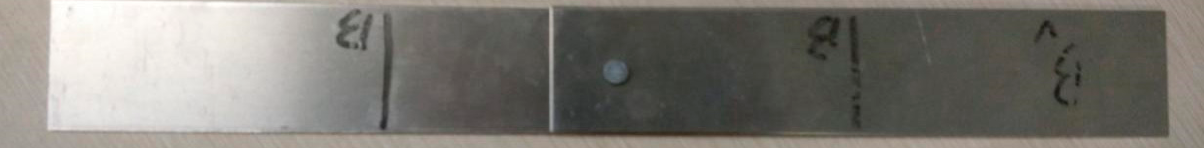
Figure 8. Automatic drilling and riveting machine pressure riveting test.